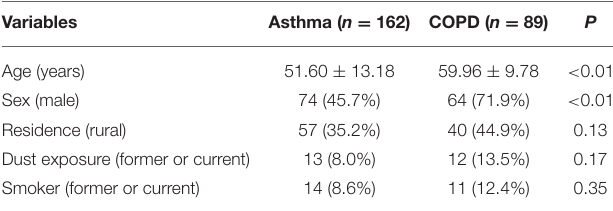
TABLE 2 | Comparisons of demographic characteristics between asthma and COPD